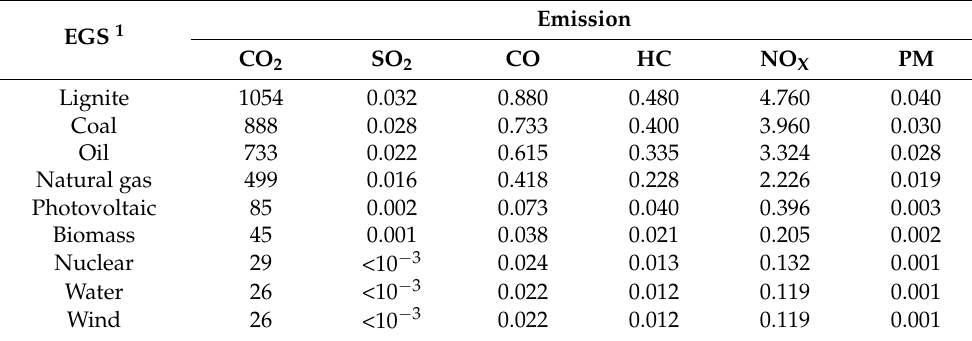
Table 3. Specific greenhouse gas (GHG) emission depending on the electricity generation source in CO 2 emission in g/kWh. [69].